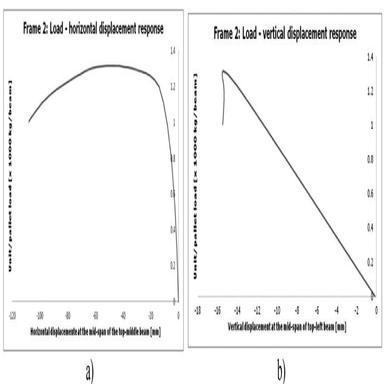
Load-displacement response of SR2: a) load-horizontal displacement and b) load-vertical displacement.